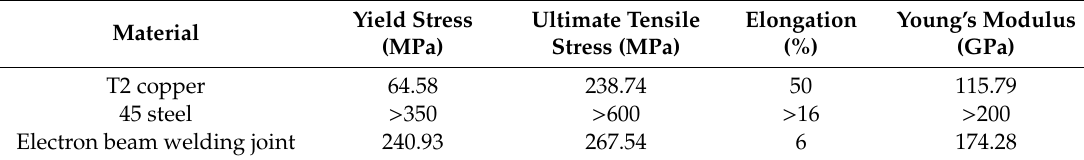
Table 4. The mechanical parameter comparison between the joint and the base